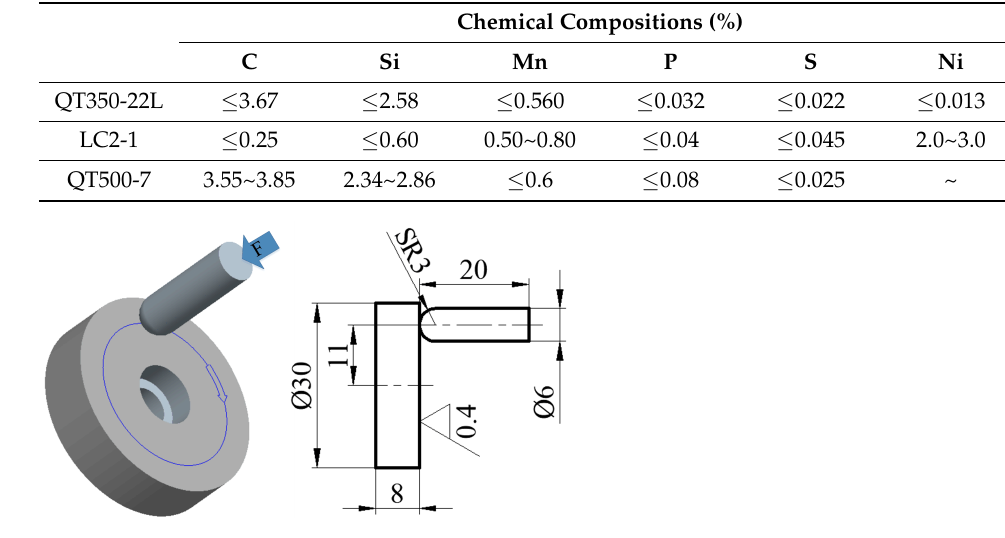
Figure 2. Test samples and schematic data of sliding wear testing.